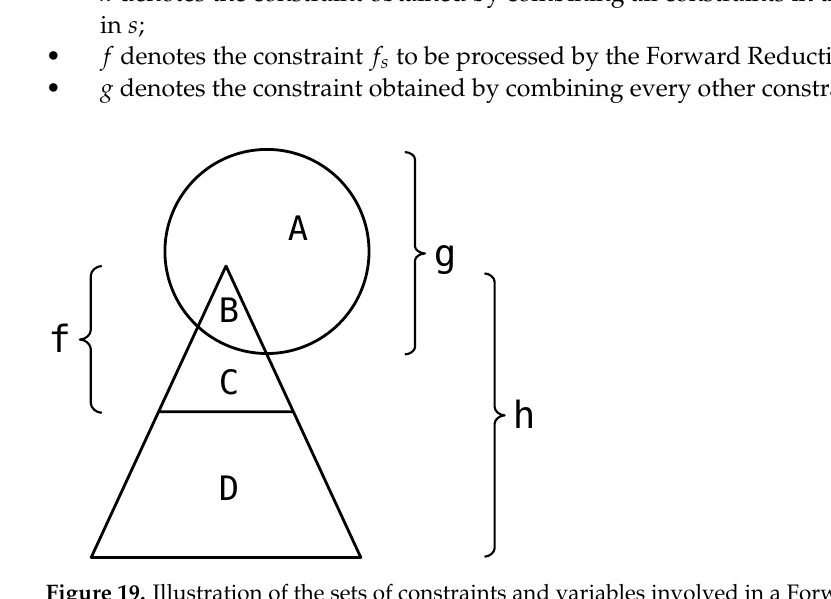
Figure 19. Illustration of the sets of constraints and variables involved in a Forward Reduction step. The names used are exactly those from Theorem